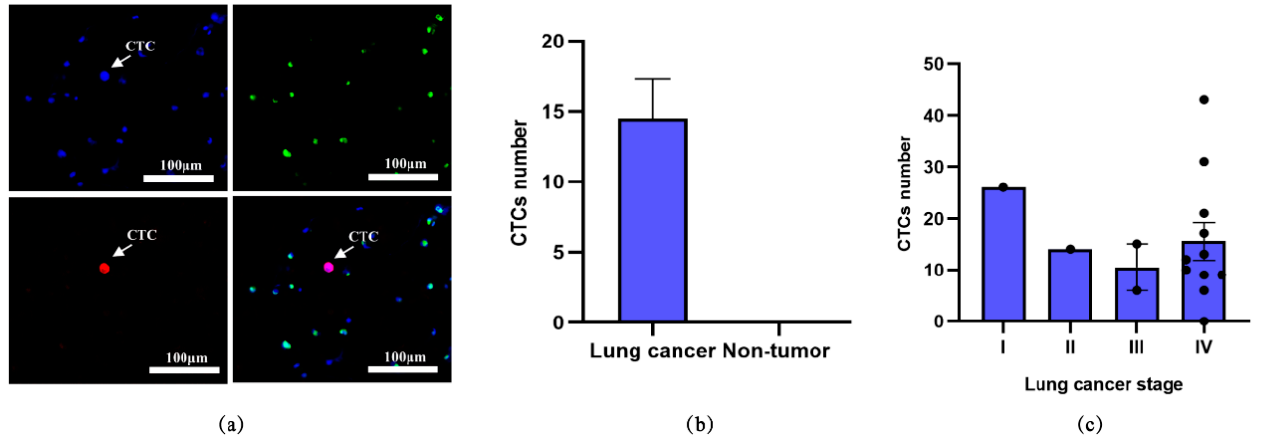
Figure 3. Analysis of captured CTCs from blood samples of patients. ( a ) Representative fluorescent staining images of CTC detected in a blood sample of a lung cancer patient. The blue color referred to nuclear staining (DAPI), the green color referred to CD45, and the red color demonstrated CK expression. Magnification, ×200. ( b ) The average number of CTCs in lung cancer patients ( n = 16) and non-tumor patients ( n = 4). ( c ) The average number of CTCs in lung cancer patients of different stages (Stage I, n = 1; Stage II, n = 1; Stage III, n = 2; Stage IV, n = 11).